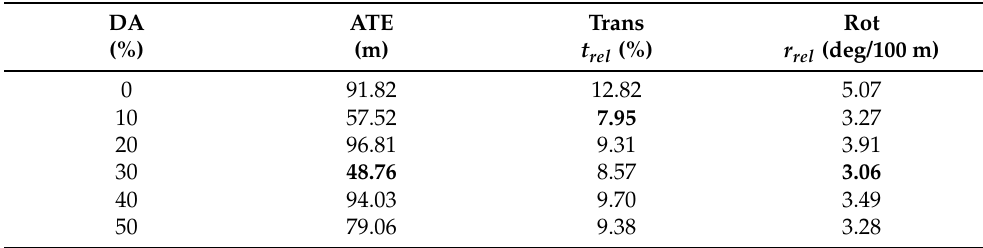
Table 2. Effects of varying quantities of DA on MPO-Net (the least error results are high-lighted in bold